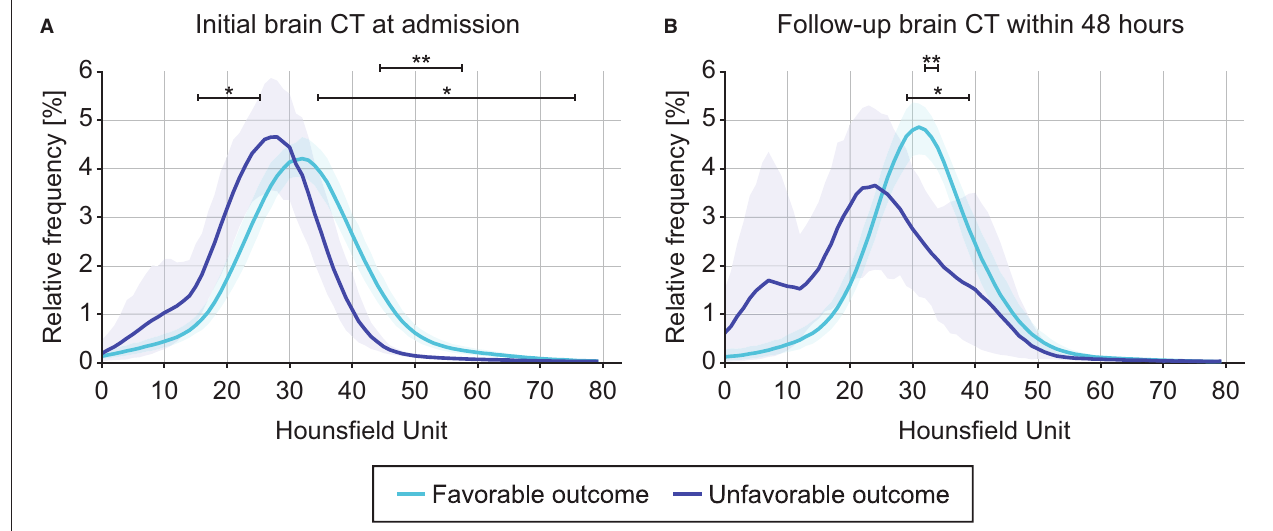
FIGURE 3 | Comparison of intracranial densitometry by outcome favorability based on the initial brain CT at admission (A) and follow-up brain CT within 48h (B) . Blue = favorable outcome group, purple = unfavorable outcome group. The bold line and shaded area denote the mean and range of the 95% confidence interval, respectively. Significance at p < 0.05* and p < 0.001**.